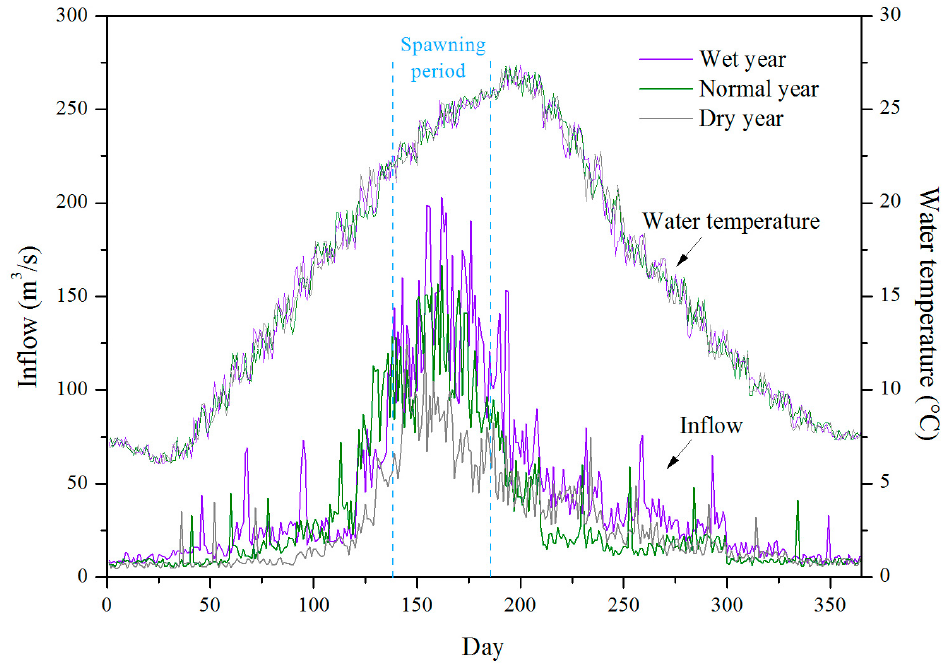
Figure 2. A graph of annual reservoir inflow and water temperature in the study area.